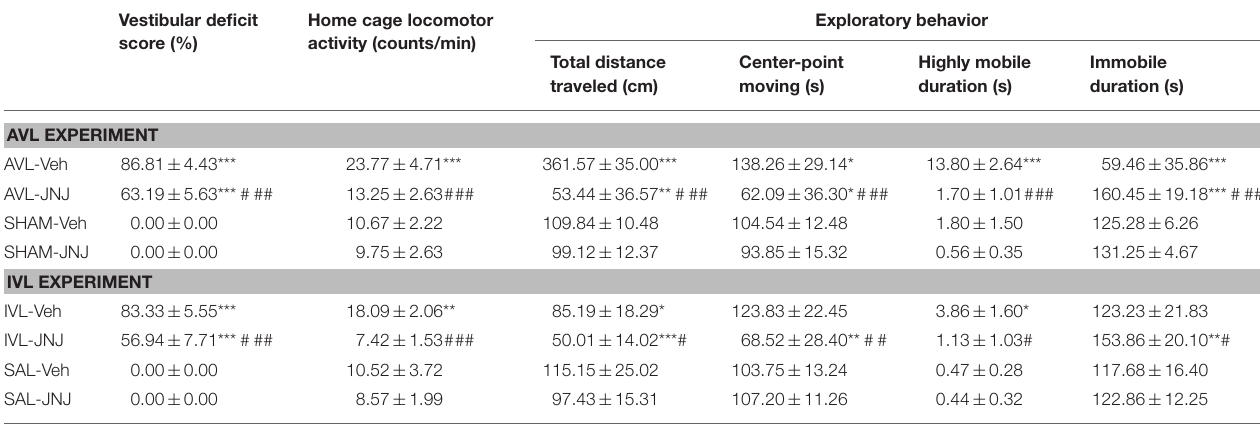
TABLE 3 | Effects of the histamine H 4 receptor antagonist JNJ7777120 on the vestibular deficit syndrome, home cage locomotor activity and exploratory behavior at 72 h post-vestibular lesion (VL). Vestibular deficit score (%)